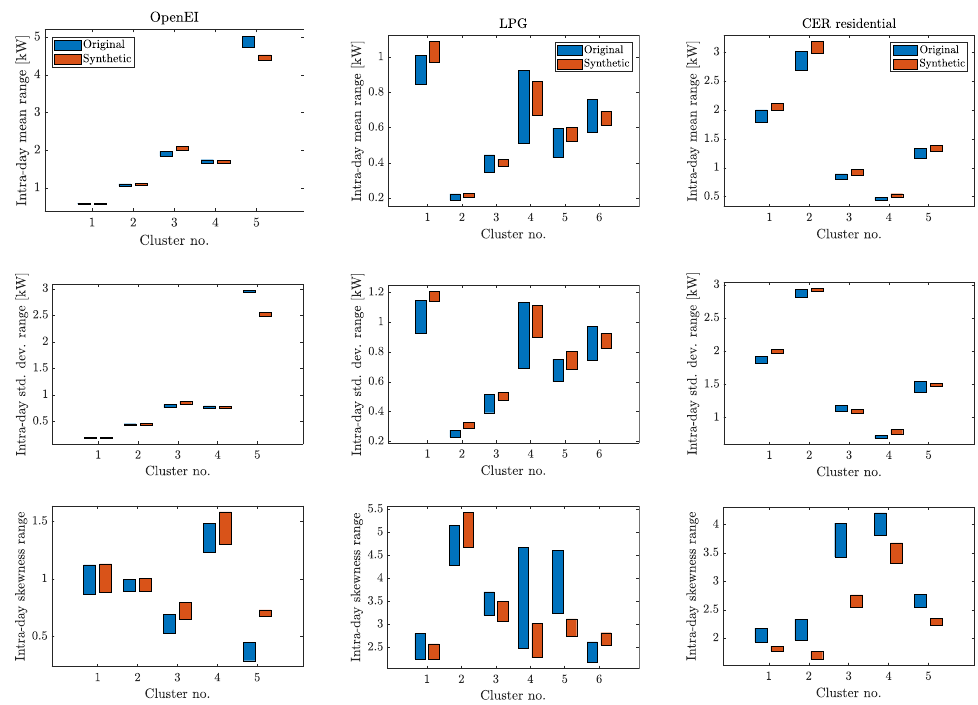
Figure 7. Range of variation of the mean, standard deviation and skewness values of the estimated PDFs of the original LPs (in blue) and the corresponding SLPs (in red), respectively, within a typical winter day. Each pair of bars within every plot refers to one of the identified clusters. The columns of the matrix of plots refer to the three explored data sets, while the rows refer to the analyzed statistical